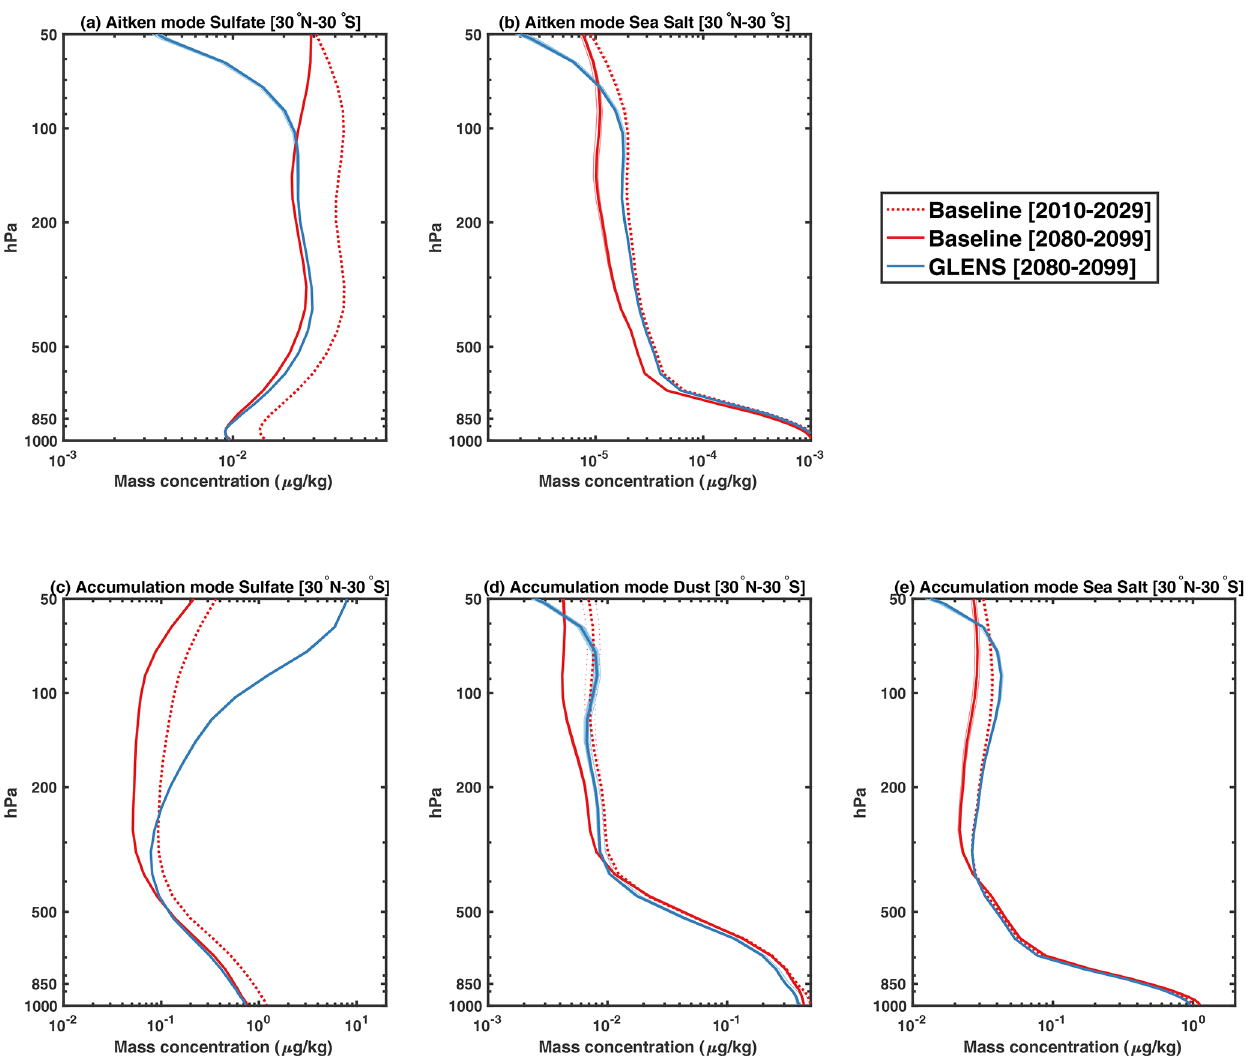
Figure 3. Mass concentration (in micrograms per kilogram of air) of sulfate, dust and sea salt in the Aitken (smallest) mode and accumulation (intermediate) mode, between 30 ◦ N and 30 ◦ S. Thinner lines show the single ensemble realizations, while the thicker lines show the ensemble